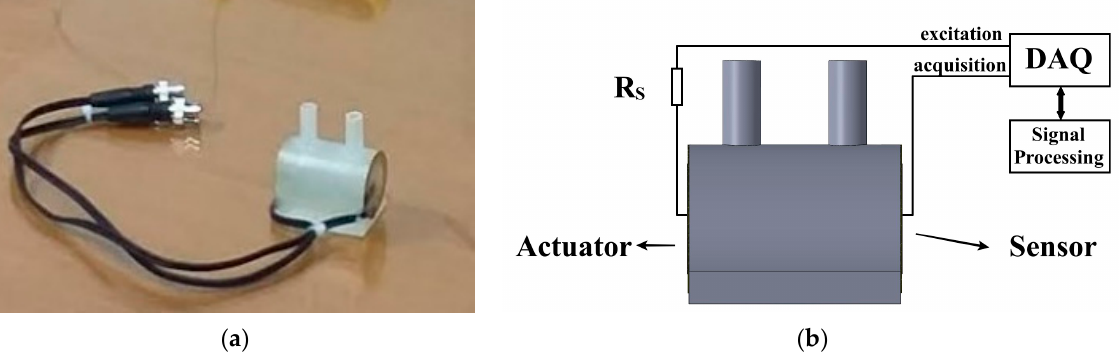
Figure 2. Experimental setup: ( a ) test tube and ( b ) experimental setup diagram. Obs.: Rs is a resistor which limits the current of the DAQ (data acquisition system).